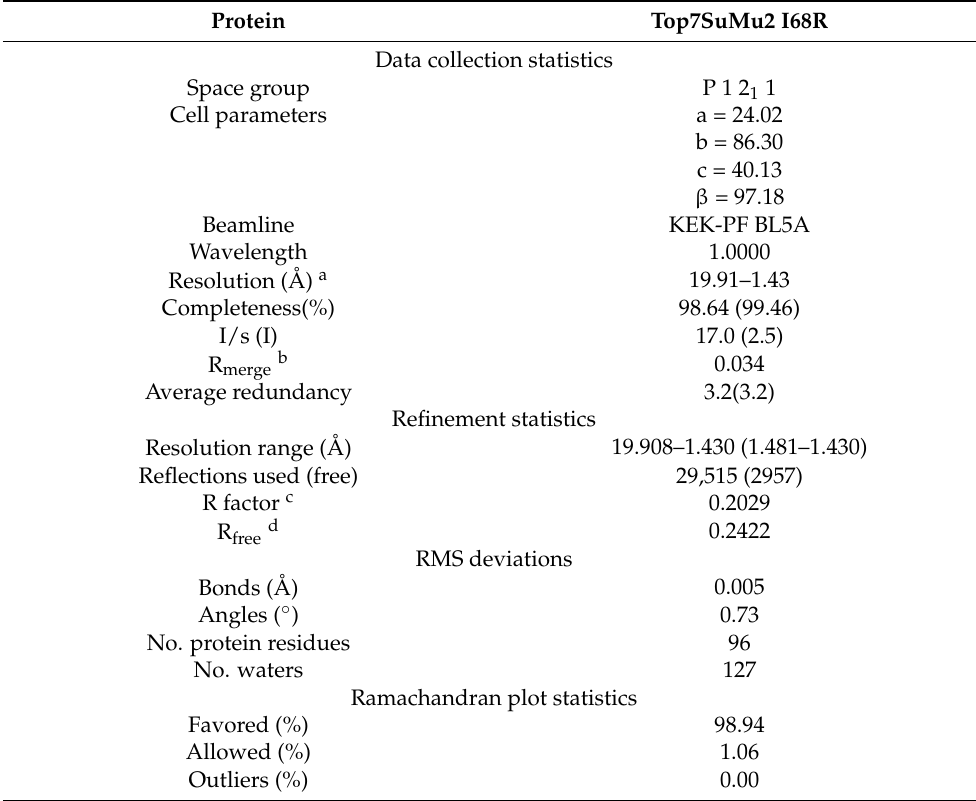
Table 1. Statistics for the crystal